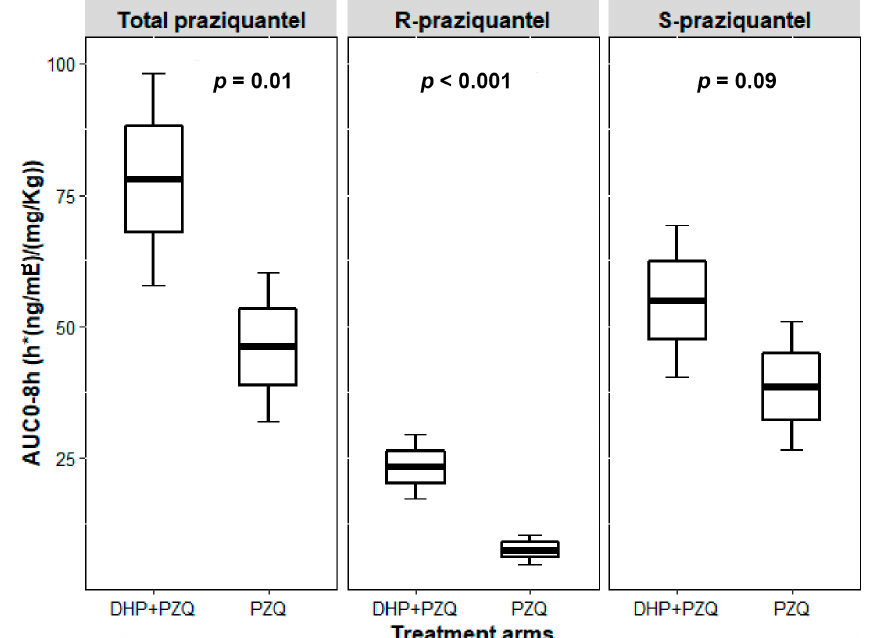
Figure 2. Boxplots comparing dose-normalized AUC 0–8h for total PZQ, R-PZQ and S-PZQ between PZQ versus PZQ + DHP treatment arms. Boxes represent mean ± SE, error bars represent mean ± 1.96*SE.